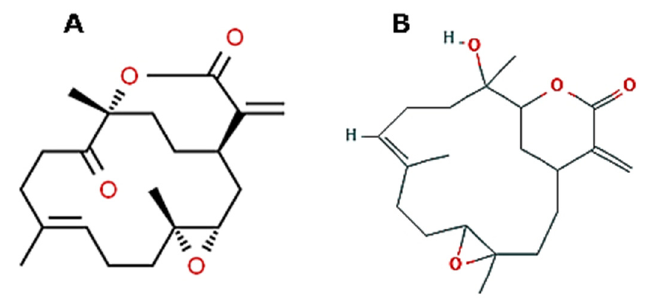
Figure 11. ( A ) 2D structure of 11-dehydrosinulariolide; http: // www.chemspider.com / Chemical- Figure 11. A ) 2D structure of 11-dehydrosinulariolide; http://www.chemspider.com/Chemical- Structure.10470882.html. ( B ) 2D structure of sinularin; https: // pubchem.ncbi.nlm.nih.gov / compound / Structure.10470882.html. B ) 2D structure of sinularin; https://pubchem.ncbi.nlm.nih.gov/ Sinularin#section = compound/ Sinularin#section=2D-Structure.